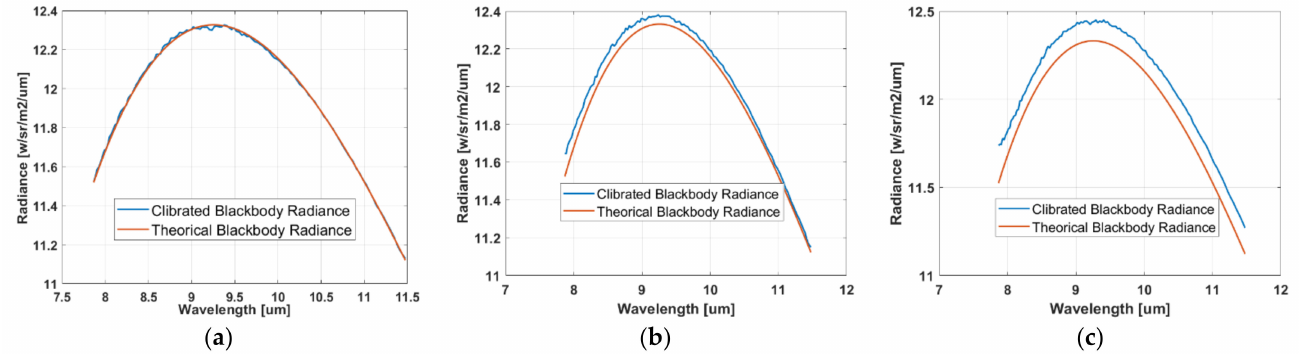
Figure 3. Radiometric calibration error at various sensor internal temperature differences (TDs): ( a ) TD = 0.1 K; ( b ) TD = 0.9 K; ( c ) TD = 2.2